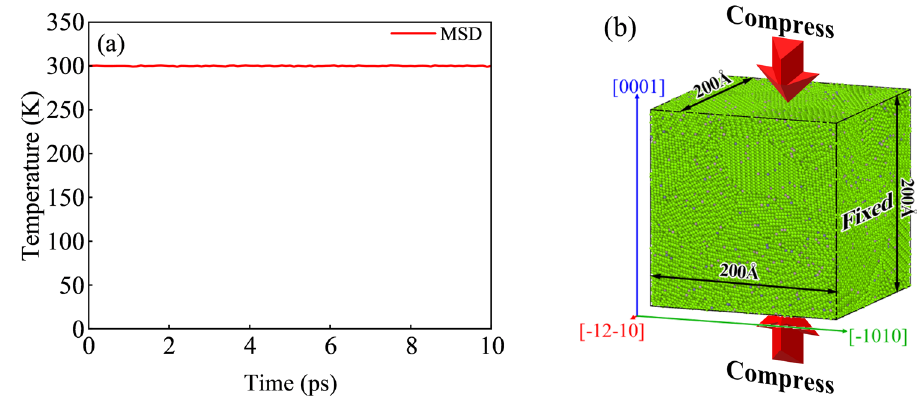
Figure 2: Plane strain compression: ( a ) the change of temperature during relaxation and ( b ) process